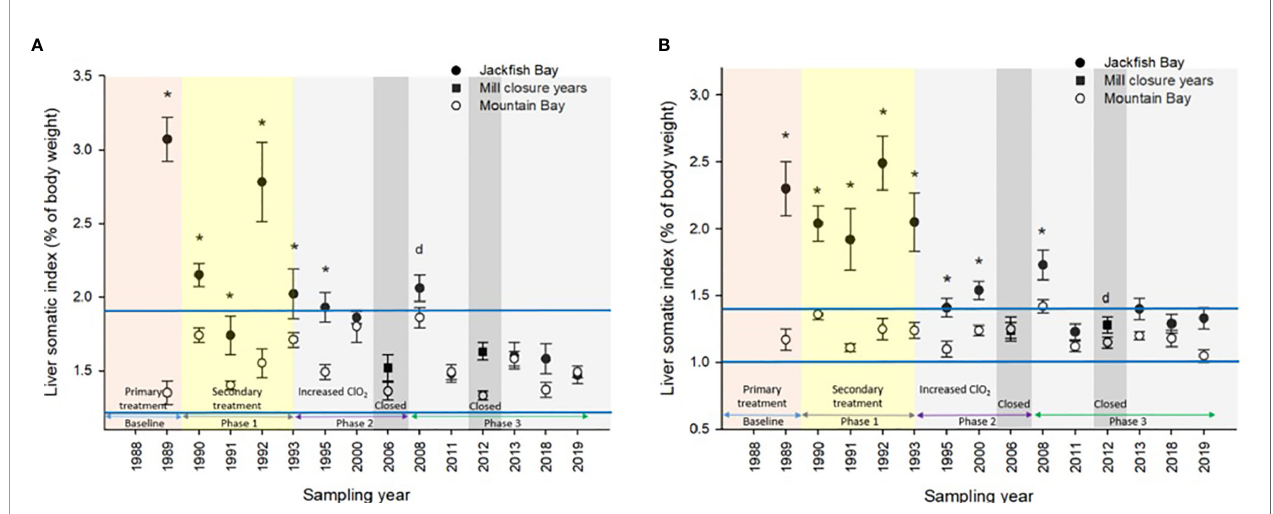
FIGURE 4 | Liver somatic indices (± SE) of (A) female and (B) male white sucker ( Catostomus commersoni ) from Jack fi sh Bay and Mountain Bay, during the fall from 1988 to 2019. Asterisks* represent a signi fi cant difference (p ≤ 0.05) between sites within years, “ d ” represents an interaction between sites, horizontal blue bars represent the 30 year normal range for the reference site. All data before 2008 published in Bowron et al. (35).